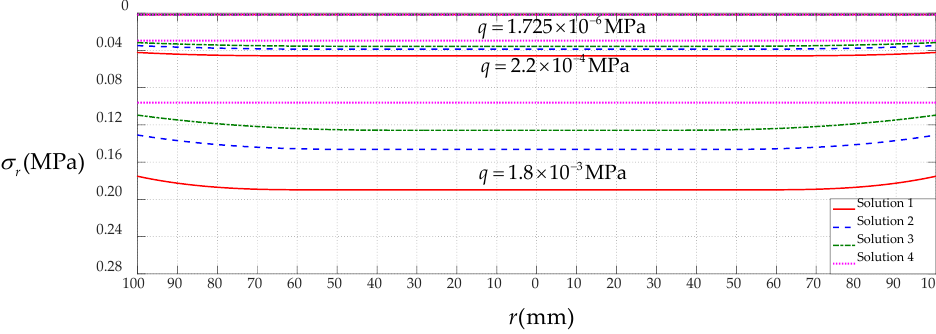
Figure 12. The variations of radial stress σ r with radial coordinate r . It can be calculated from Table 5 that for the contact radius b , the relative error of Solution 2 to Solution 1 is about 3.52% for q = 1.725 × 10 −6 MPa, 20.86% for q = 2.2 × 10 −4 MPa and 35.07% for q = 1.8 × 10 −3 MPa, the relative error of Solution 3 to Solution 1 is about 5.34% for q = 1.725 × 10 −6 MPa, 26.74% for q = 2.2 × 10 −4 MPa and 44.12% for q = 1.8 × 10 −3 MPa, and the relative error of Solution 4 to Solution 1 is about 6.04% for q = 1.725 × 10 −6 MPa, 30.43% for q = 2.2 × 10 −4 MPa and 54.57% for q = 1.8 × 10 −3 MPa, while for the maximum stress σ m , the relative error of Solution 2 to Solution 1 is about 4% for q = 1.725 × 10 −6 MPa, 8.56% for q = 2.2 × 10 −4 MPa and 30.14% for q = 1.8 × 10 −3 MPa, the relative error of Solution 3 to Solution 1 is about 8.24% for q = 1.725 × 10 −6 MPa, 22.39% for q = 2.2 × 10 −4 MPa and 33.68% for q = 1.8 × 10 −3 MPa, and the relative error of Solution 4 to Solution 1 is about 8.79% for q = 1.725 × 10 −6 MPa, 35.65% for q = 2.2 × 10 −4 MPa and 49.42% for q = 1.8 × 10 −3 MPa. Therefore, the minimum relative error is the relative error of Solution 2 to Solution 1, but for the case of q = 1.8 × 10 −3 MPa and g = 10 mm, may be as high as 35% for the contact radius b and 30% for the maximum stress σ m . Moreover, from Figure 11, it can also